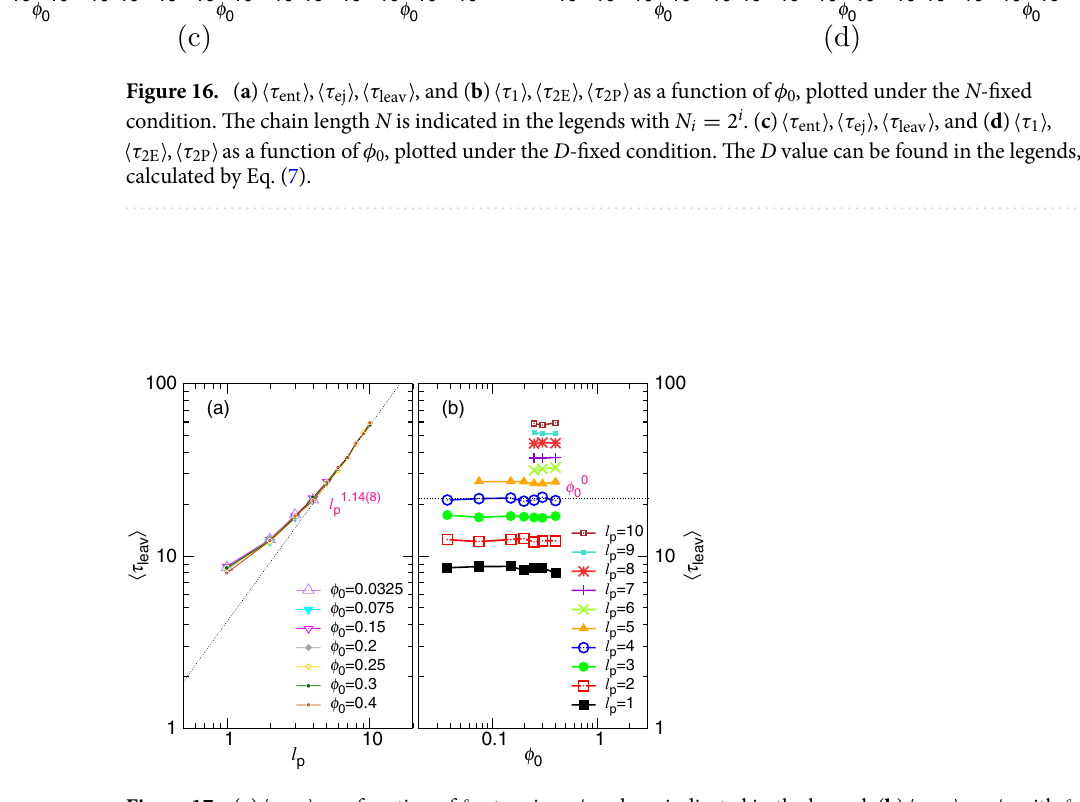
Figure 17. ( a ) being fixed. The chain length is